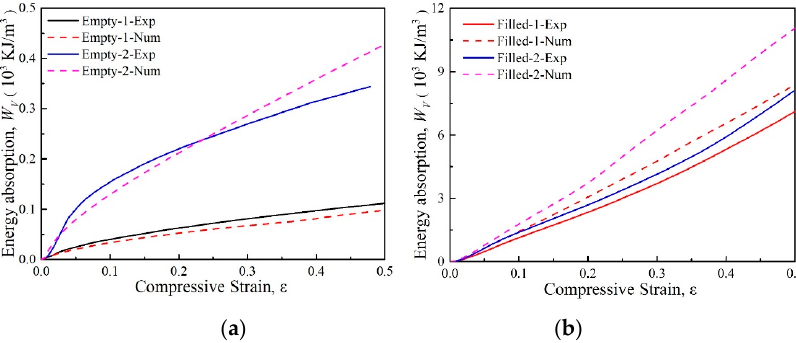
Figure 5. Measured and simulated energy absorption per volume of the Y-shape cored sandwich panels. ( a ) Empty panel; ( b ) aluminum foam-filled panel.